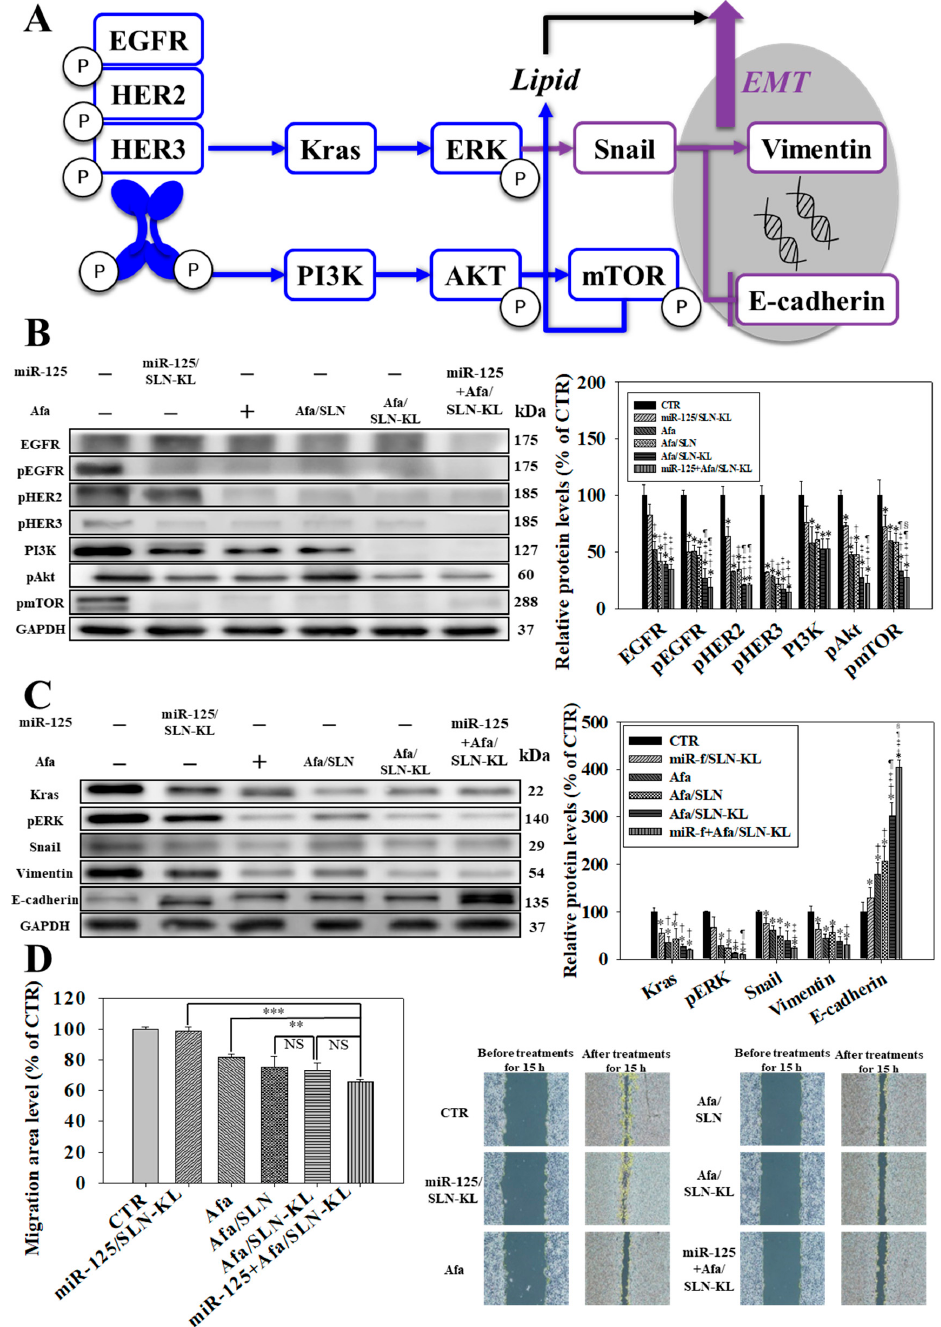
Figure 3. Effects of various miR-125 and/or Afa formulations on EGFR pathway in AGS cells. ( A ) Scheme of EGFR pathway. ( B ) ( Left ) Effect of various formulations of miR-125 (100 nM) and/or Afa (IC 30 : 300 nM) on expression of PI3K/Akt/mTOR pathway after treatment for 24 h on AGS cells. ( Right ) Quantification of relative protein levels of PI3K/Akt/mTOR pathway. ( C ) ( Left ) Effect of various formulations of miR-125 (100 nM) and/or Afa (IC 30 : 300 nM) on expression of Kras/Erk pathway after treatment for 24 h on AGS cells. ( Right ) Quantification of the relative protein levels of Kras/Erk pathway. ( B , C ) * p < 0.05 compared with control (CTR), † p < 0.05 compared with miR-125/SLN-KL, ‡ p < 0.05 compared with Afa, ¶ p < 0.05 compared with Afa/SLN, and § p < 0.05 compared with Afa/SLN-KL by using Student’s t -test analysis. ( D ) (Right) Migration assay after treatment of various formulations for 15 h. (Left) Quantification of relative percentages of cell- migration area. Migration area (% of area at 0 h) = 100% − (Blank area (15 h)/Blank area (0 h) × 100% (NS, not significant; statistical significance at ** p < 0.01; *** p <